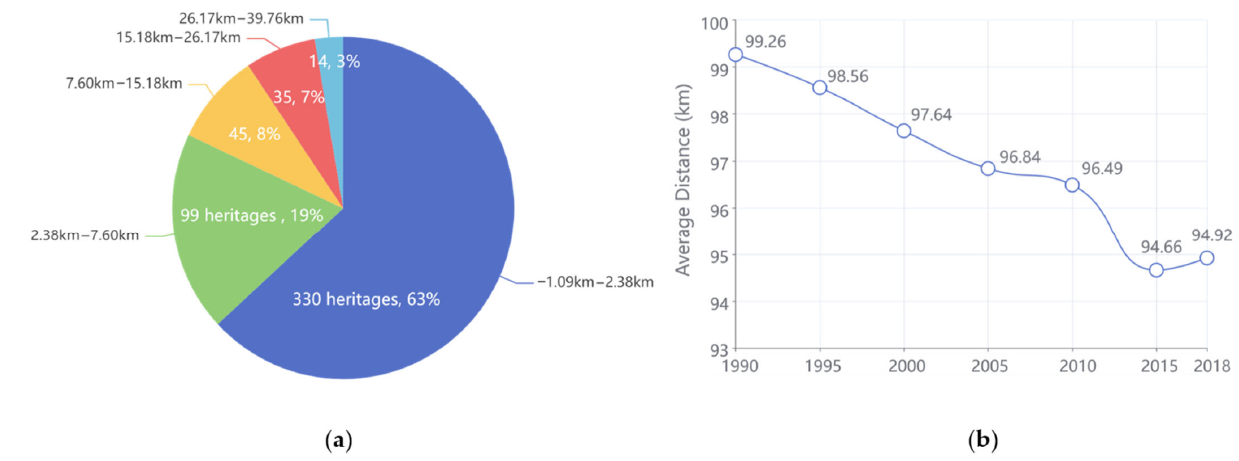
Figure 6. Distance variation between world cultural heritage sites and neighbouring towns in 1990–2018: ( a ) distribution of distance variation; ( b ) the trend of variation in average distance. Table 5. Average rate of distance variation between world cultural heritage sites and neighbouring towns. Periods